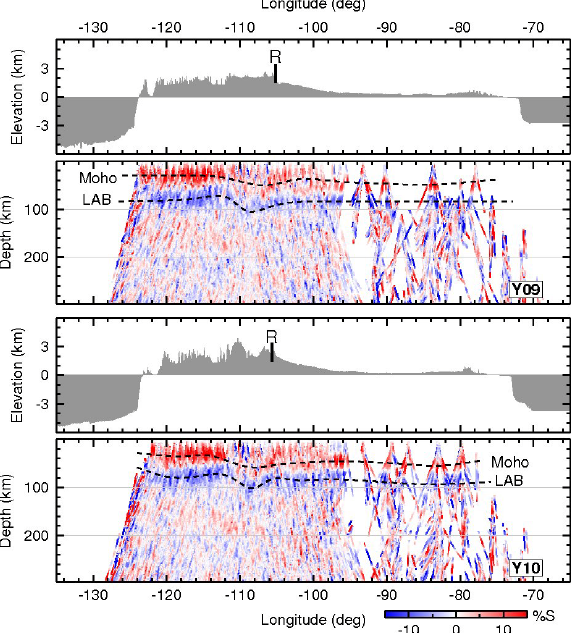
Fig. 5. Migrated S receiver functions along profiles Y05 and Y06 as in Fig. 3. Migrated S receiver functions along profiles Y05 and Y06 as in Fig. 3.